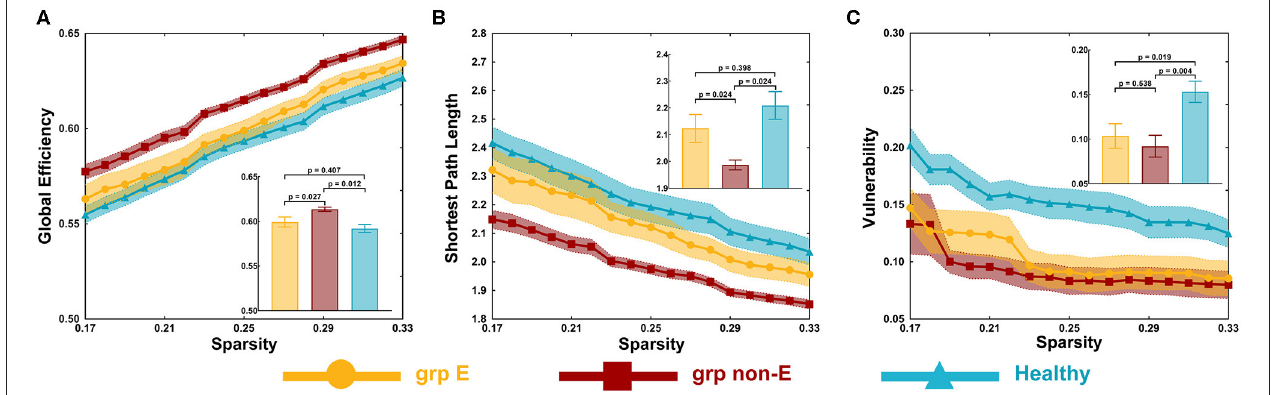
FIGURE 2 | Global topological properties. (A) Global efficiency. (B) Shortest path length. (C) Vulnerability. P -value threshold = 0.05. Grp E = GRE group. Grp non-E = non-GRE group.